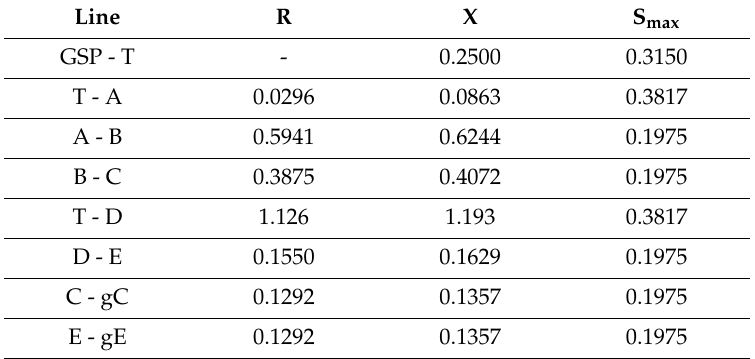
Table 3. Line and transformer parameters (resistance R, reactance X and maximum apparent power flow limit S max ) for the distribution network. All data are given as per unit values on a 100 MVA